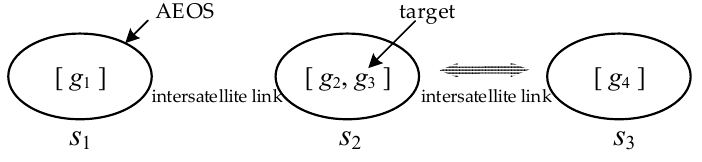
Figure 4. An example of local optimum where a s 1 = { g 1 }, a s 2 = { g 2 , g 3 }, and a s 2 = { g 4 }.